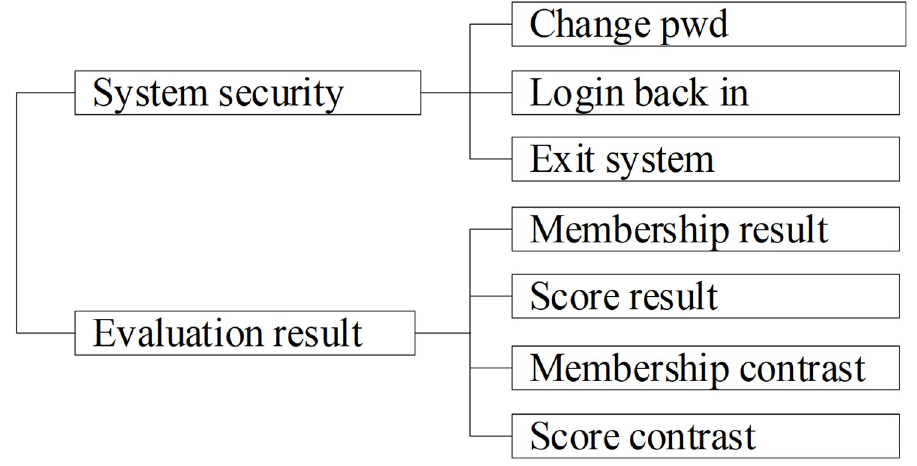
Fig 4. Function modules of Mine administrator.